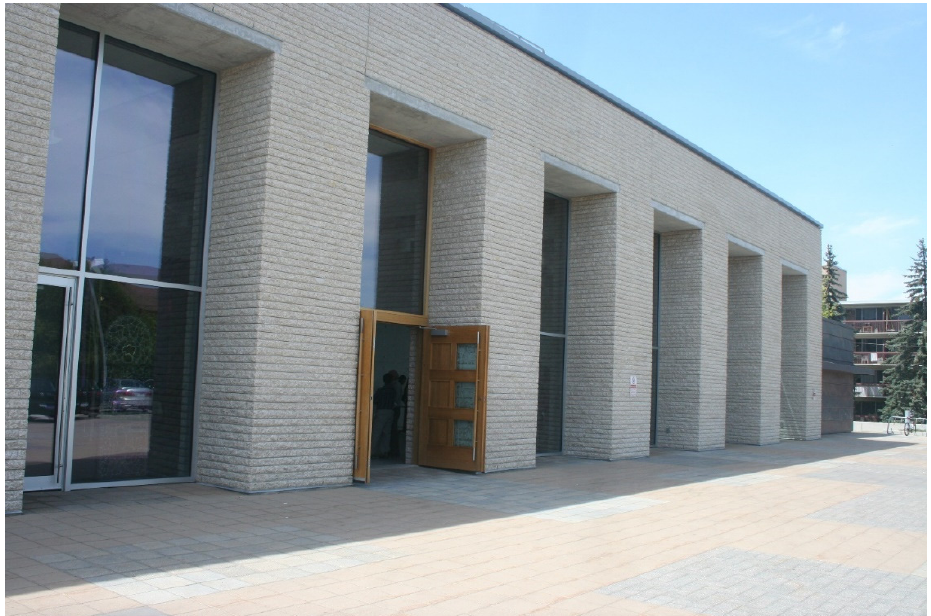
Figure 15. View of the ceremonial entrance to the narthex from the piazza showing the Tyndall Stone cladding high-lighting 6 of the 7 deep set arches referencing the Passionist motherhouse in Rome (Credit: Roberto Chiotti).